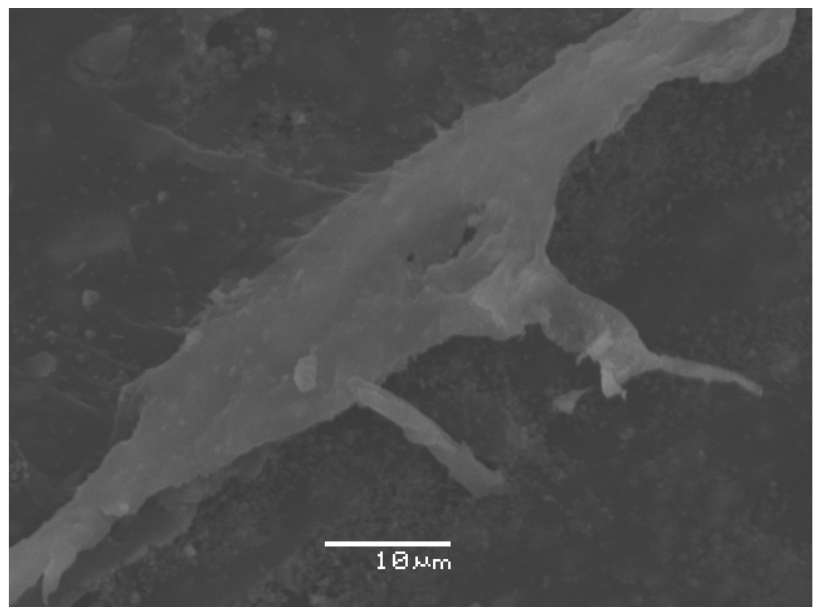
Figure 8. SEM image of the macro-crack on test specimen